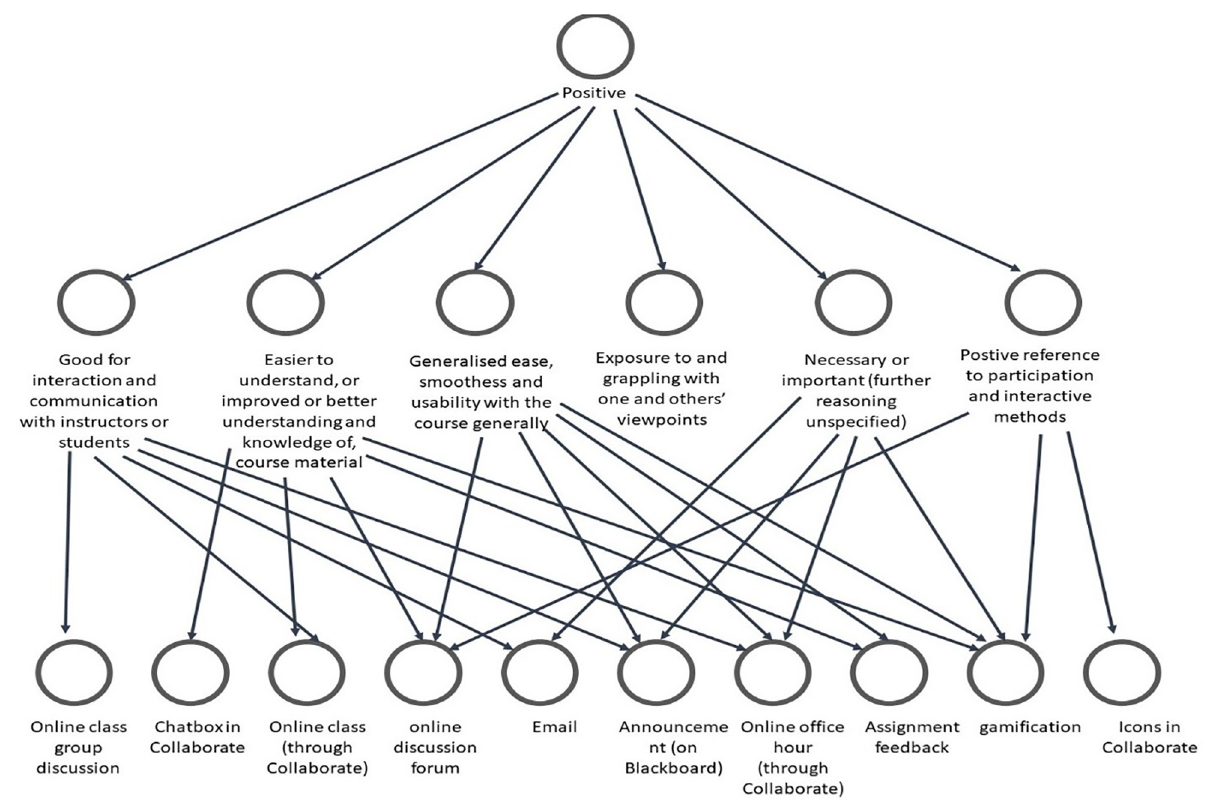
Fig 8. Codes associated with positive themes regarding tools for consideration in the